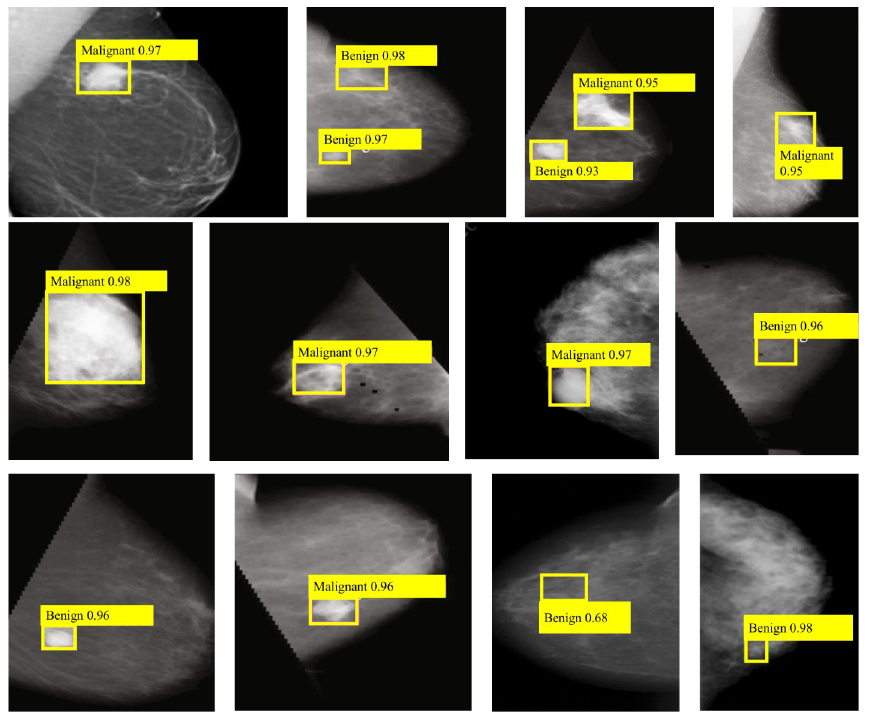
Fig 5. Results of breast tumor detection and classification using SPN-TS